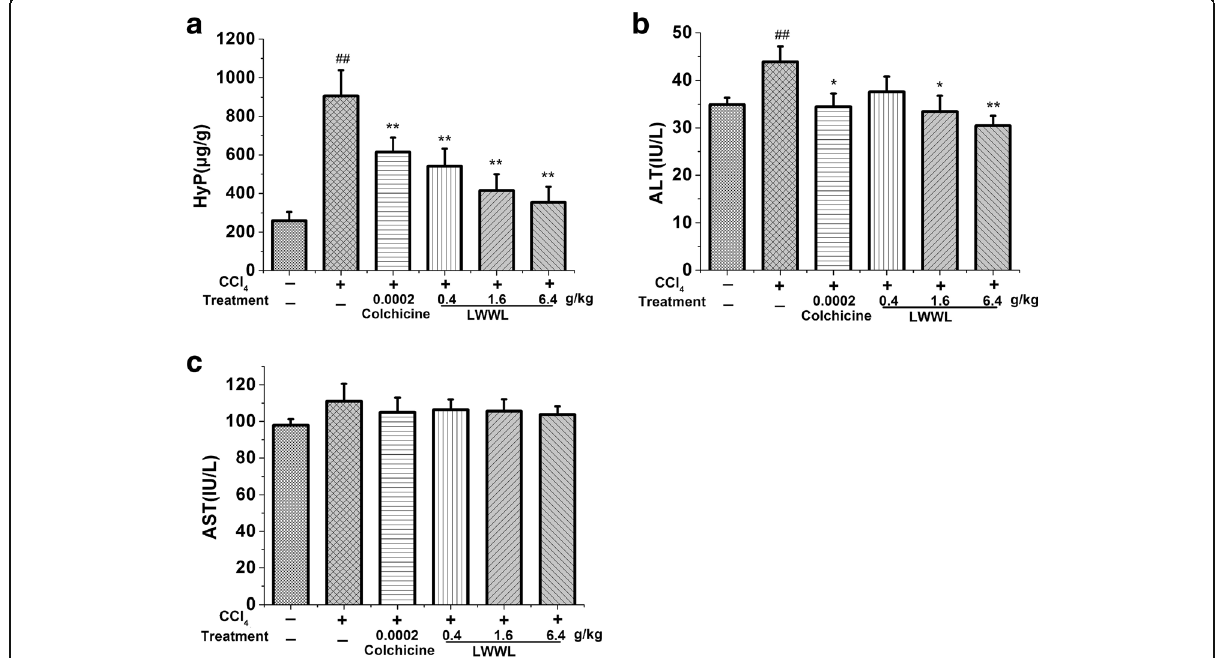
Fig. 2 LWWL attenuated liver function and the hydroxyproline content in rats. a Effect of LWWL on hydroxyproline levels in liver tissue; b Effect of LWWL on serum ALT levels; c Effect of LWWL on serum AST levels. ## P < 0.01 vs. normal group; * P < 0.05, ** P < 0.01 vs. model